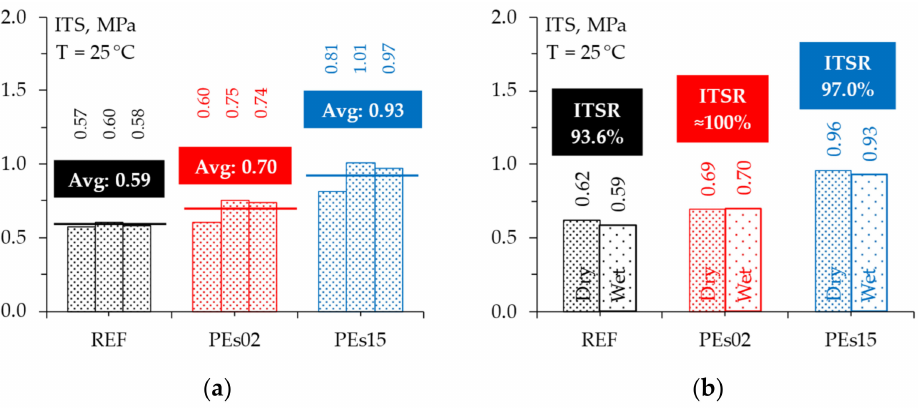
Figure 19. The moisture resistance: ( a ) ITS of wet-conditioned samples; ( b ) ITSR